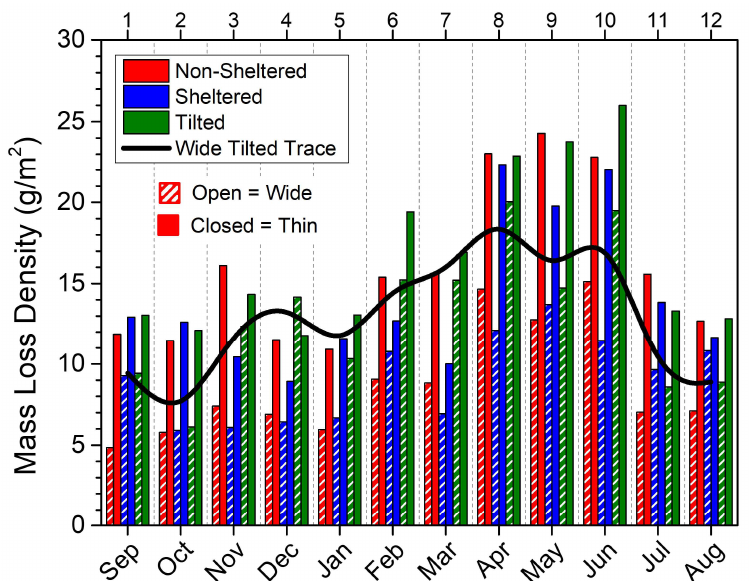
Figure 7. A time lapse column plot of the monthly mass loss densities observed for all of the exposure conditions. Exposure conditions are color-coded while Wide vs. Thin samples are distinguished with open or closed columns. The Wide Tilted sample was isolated as an overlaid scatter plot to highlight the overall trend in corrosivity over the course of the year.